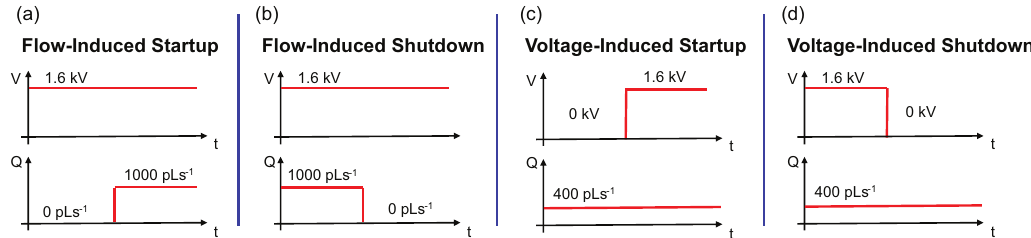
Figure 6. Qualitative plots of voltage and flow rate that describe the startup and shutdown of an electrospray thruster. Flow-induced startup ( a ) and flow-induced shutdown ( b ) represent the nominal method of thruster operation. Voltage-induced startup ( c ) and voltage-induced shutdown ( d ) represent off-nominal methods of thruster